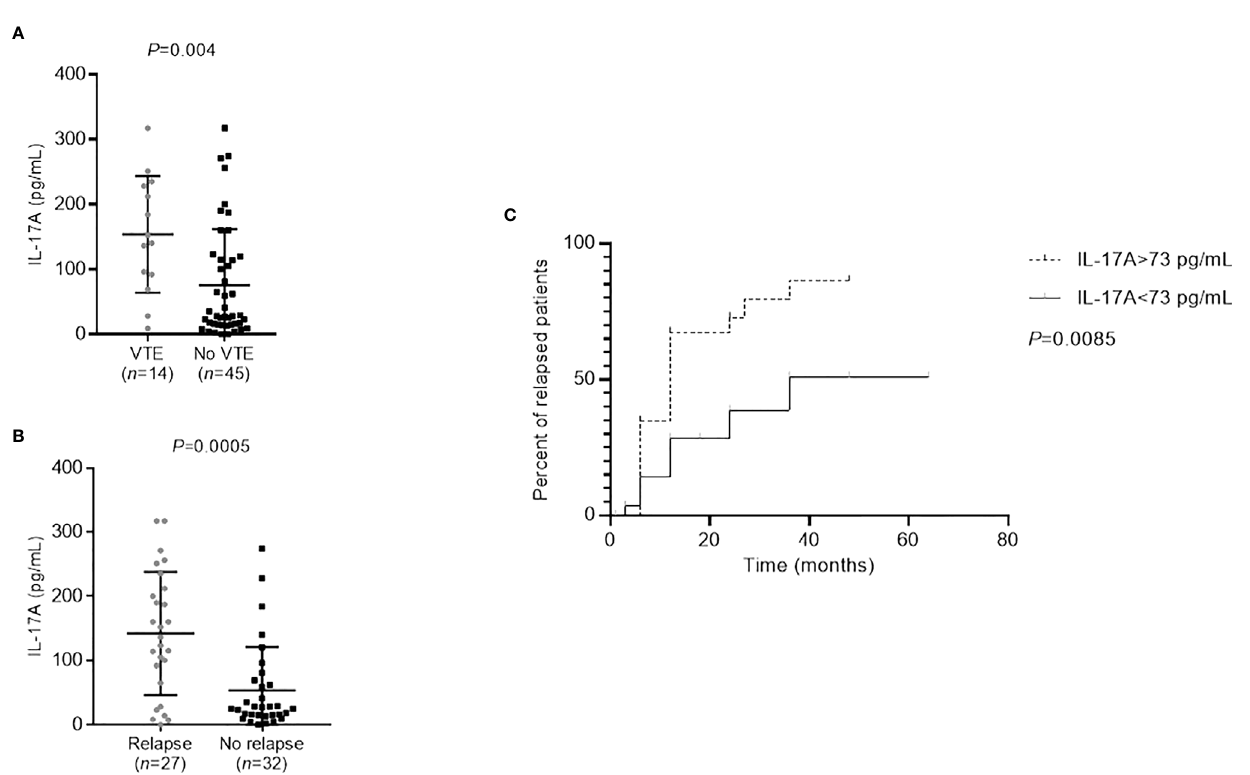
FIGURE 4 | Prognosis of membranous nephropathy (MN) patients according to the level of cytokines. (A) Patients with thromboembolic complications (VTE) had signi fi cantly higher IL-17A levels than those without ( P =0.004). Statistical signi fi cance was determined by a Mann-Whitney test. (B) Patients who relapsed within one year after rituximab treatment had signi fi cantly higher IL-17A levels than those who did not relapse ( P =0.0005). Statistical signi fi cance was determined by a Mann- Whitney test. (C) Relapse-free survival was lower in patients with higher IL-17A levels at diagnosis. The threshold of 73 pg/ml, as determined by ROC curve (sensitivity of 81% and speci fi city of 76%), was used to distinguish the patients with low or high levels of IL-17A. Kaplan-Meier analysis was used to estimate the relapse-free survival of MN patients ( n =59) based on their IL-17A level. IL, interleukin; MN, membranous nephropathy; VTE, venous thromboembolic